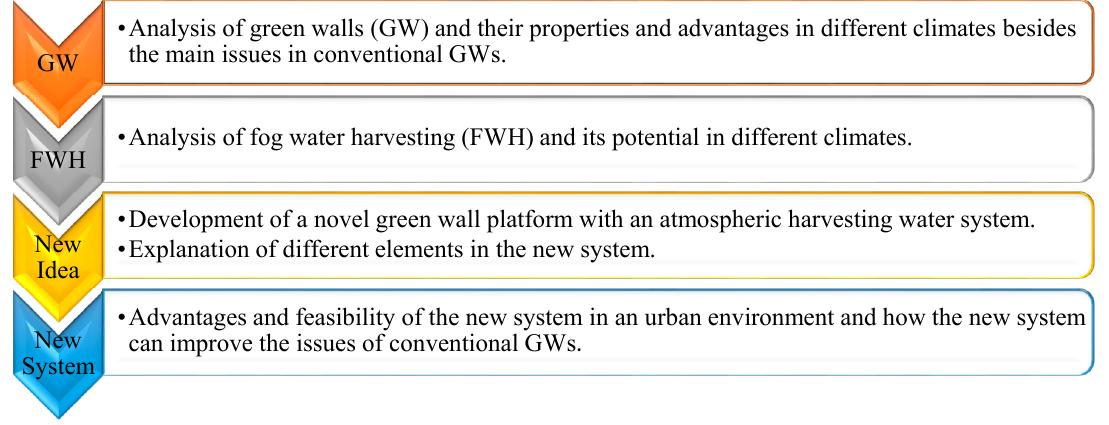
Figure 1. Analysis diagram of the study.